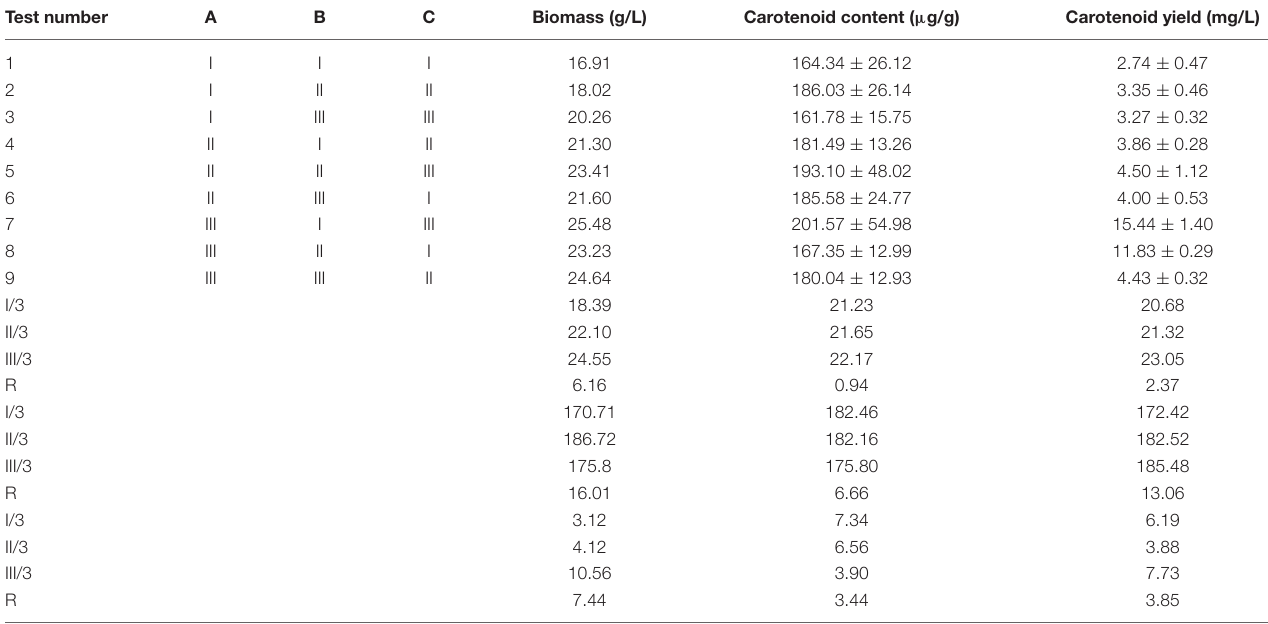
TABLE 4 | The result of the fermentation optimisation of Rhodotorula mucilaginosa TZR 2014 . Test number